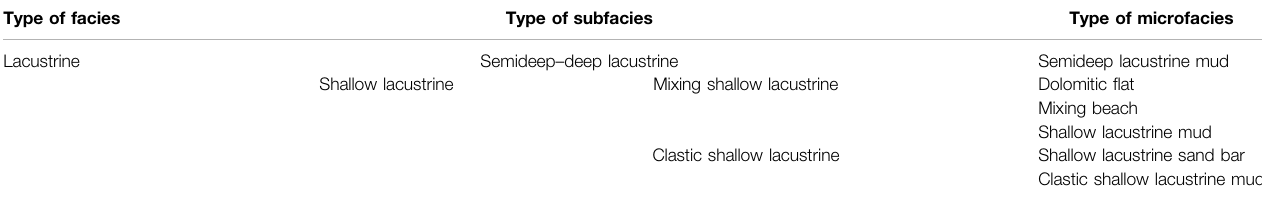
TABLE 1 | Classi fi cation of sedimentary facies in the Lucaogou Formation of the Jimsar